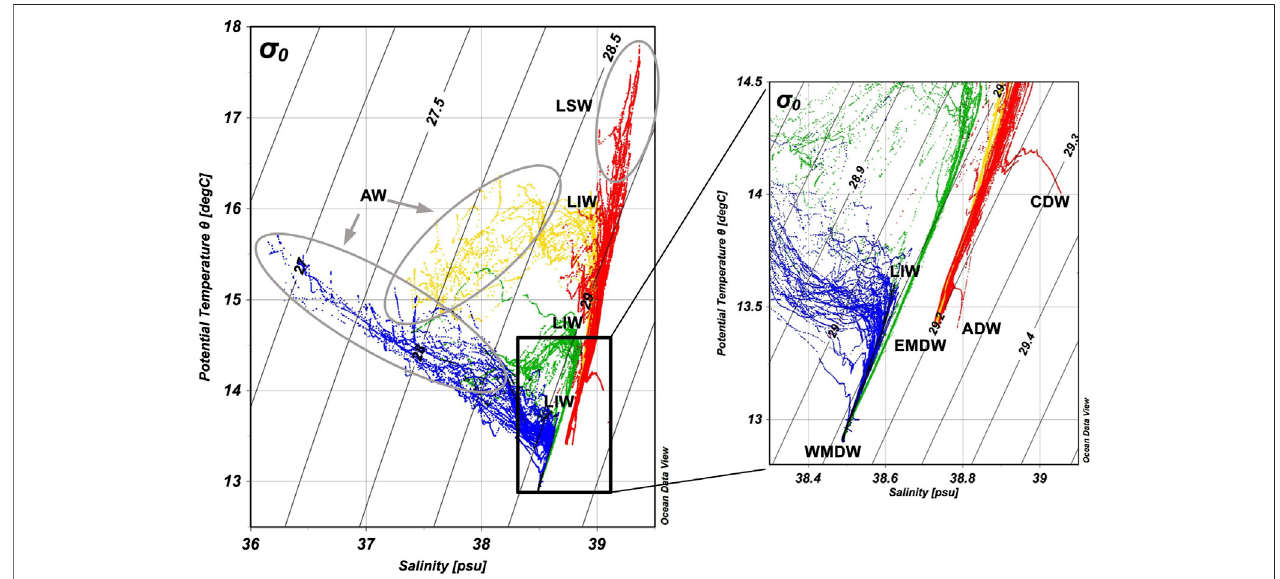
FIGURE 2 | Theta-S diagram of the stations sampled during the MSM72 cruise. The pro fi les have been grouped into four categories assigning different colors to different hydrological characteristics. Blue and green pro fi les represent stations in the WMed: Gibraltar Strait up to the Sardinia channel; Sardinia channel and the Tyrrhenian Sea, respectively. Yellow and red pro fi les represent stations sampled in the EMed: western part of the EMed (mostly in the Ionian Sea); east Ionian Sea, Otranto strait, Cretan Passage and Cretan Sea, respectively. The abbreviations of the identi fi ed main water masses are de fi ned in the text.